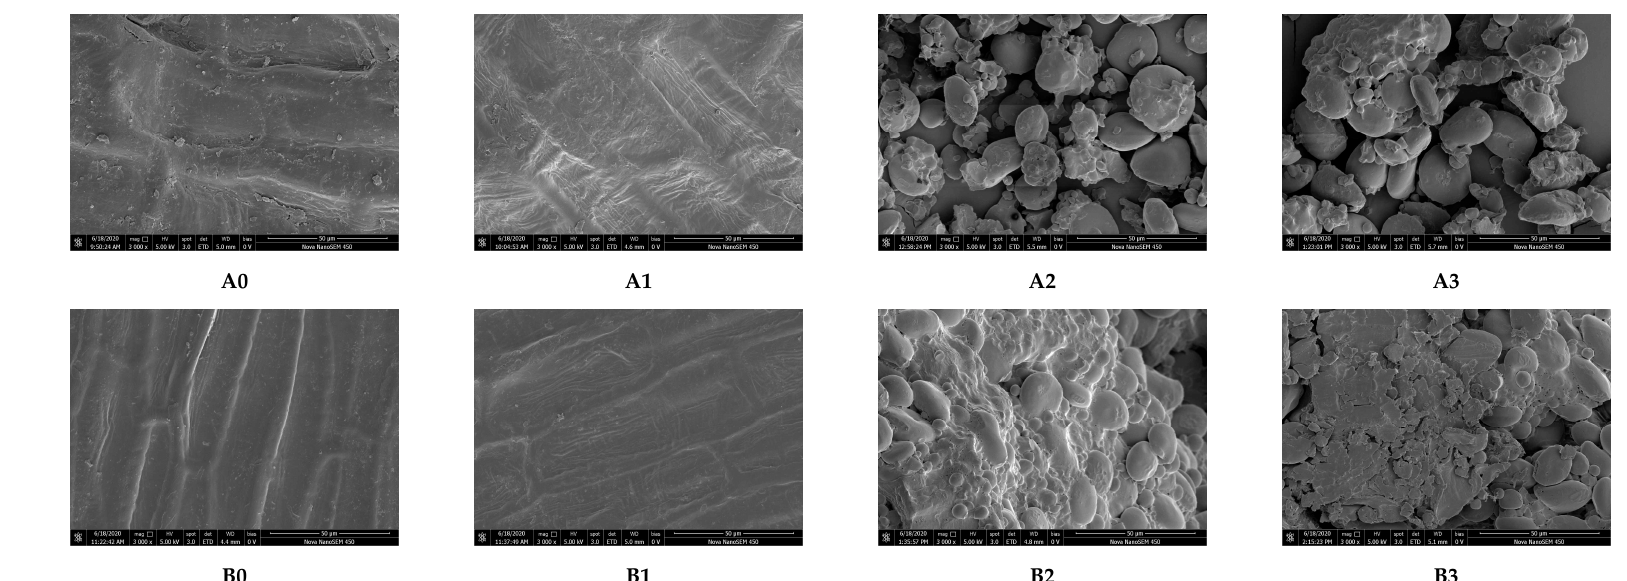
Figure 4. Scanning electron microscope (SEM) images of wheat samples with three physical structures (All images were 3000 × magnification). ( A0 , A2 , B0 , B2 ) were control samples without heating for wheat kernel surface (a w = 0.66), wheat flour, wheat kernel surface (a w = 0.99), and wheat dough, respectively. ( A1 , A3 ) were treatment samples for wheat kernel surface (a w = 0.66) and wheat flour heating at 80 °C for 5 min in HBS. ( B1 , B3 ) were treatment samples for wheat kernel surface (a w = 0.99) and wheat dough heated at 62 °C for 5 min in HBS.